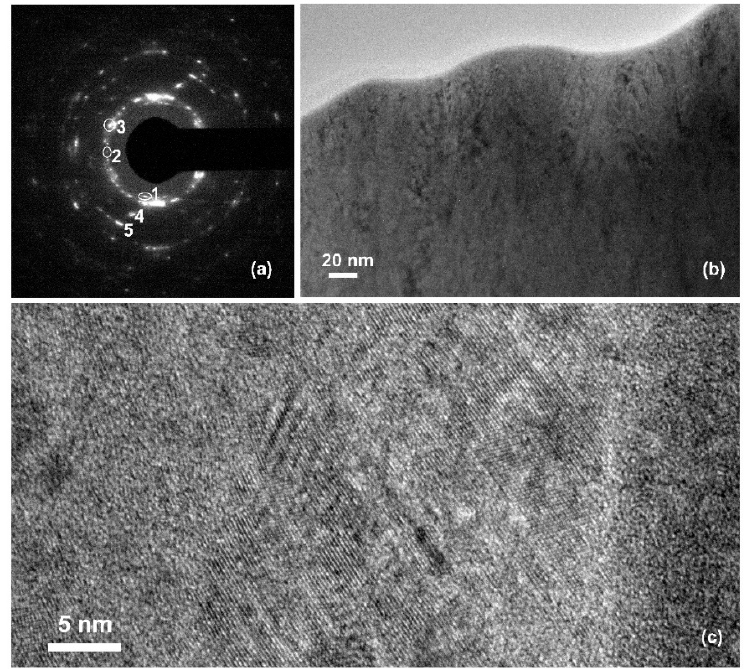
Figure 6. ( a ) SAED pattern, ( b ) Bright-field TEM micrograph of the structure and ( c ) cross-section HRTEM image of the 13% N 2